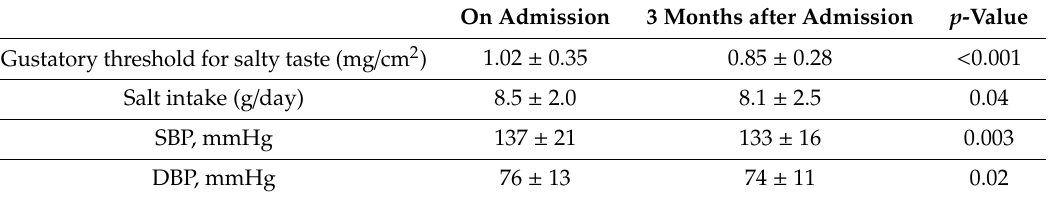
Table 2. Gustatory threshold for salty taste, salt intake, and blood pressure at admission and three months after admission in Group A.